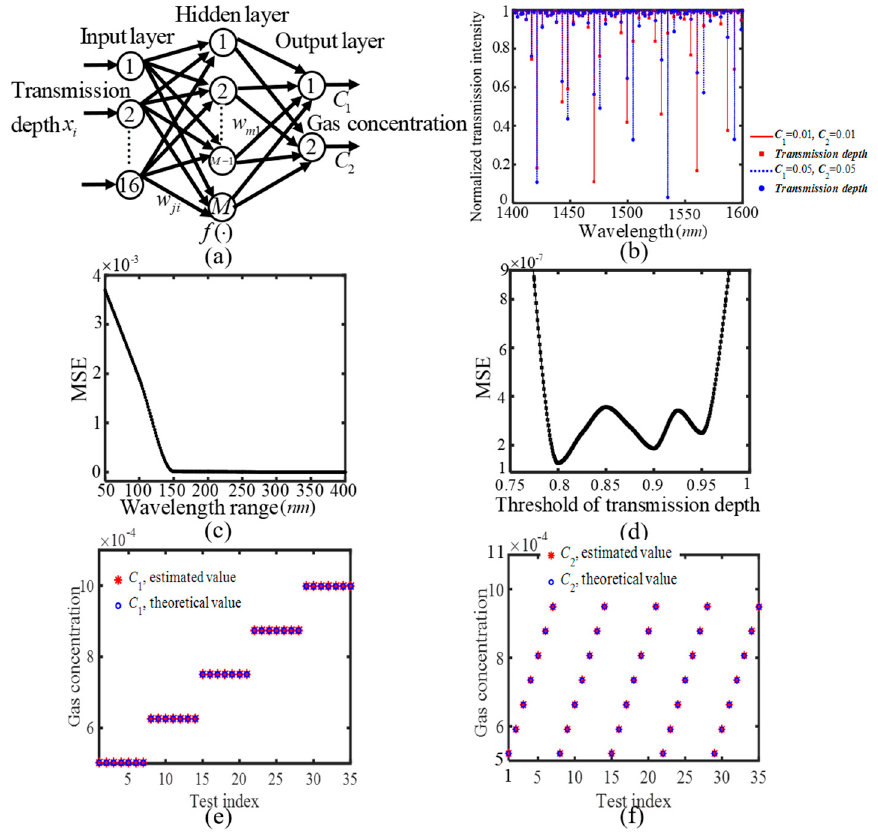
Figure 4. Multi-parameter SIMRR sensing using BP-ANN. ( a ) a BP-ANN for signal processing of the two-parameter SIMRR sensor in Figure 3a. ( b ) The simulated transmission spectra in the wavelength range of 1400–1600 nm at C 1 = C 2 = 1% or 5%. ( c ) MSE versus wavelength range, ( d ) MSE versus threshold value of transmission depth, ( e ) Comparison between the estimated values by BP-ANN and the theoretical value of gas concentration C 1 , ( f ) Comparison between the estimated values by the BP-ANN and the theoretical value of gas concentration C 2 .